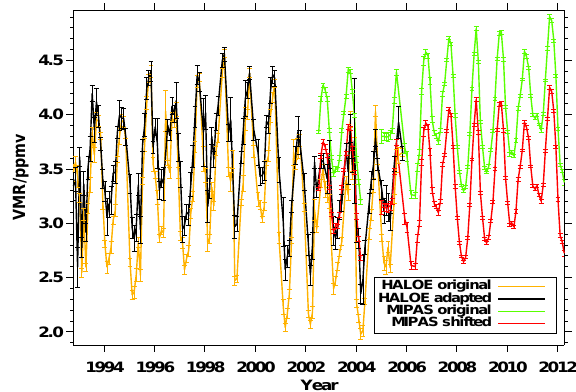
Figure 2. H 2 O time series of the original (green) and de-biased (red) MIPAS data, HALOE (yellow) and HALOE after application of the MIPAS averaging kernels (black). The altitude/latitude bin at 20 ◦ S–20 ◦ N, 17–18km is shown as an example.